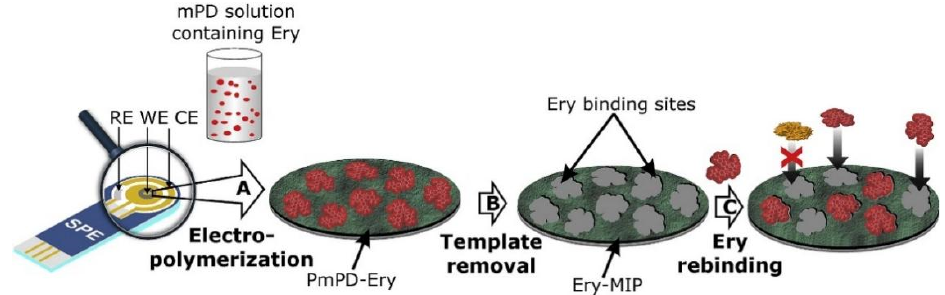
Figure 7. Schematic of the protocols for Ery-MIP film formation on the gold working electrode of a screen-printed electrode [102].